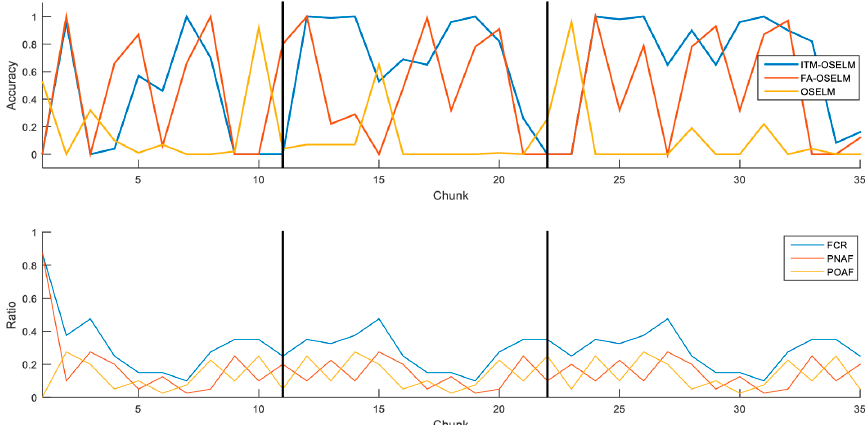
Figure 8. Accuracy change with respect to data chunks for three cycles using the KDD99 dataset. Appl. Sci. 2019 , 9 , x FOR PEER REVIEW